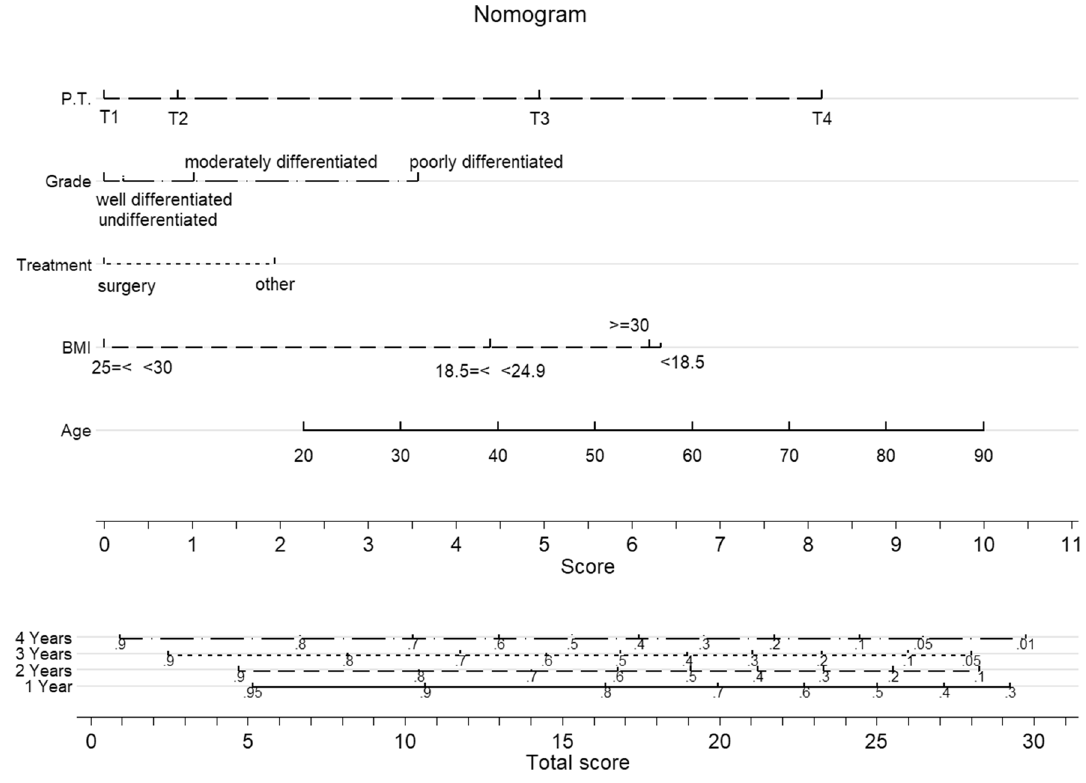
Figure 2. Predictive nomogram for survival in Gastric cancer